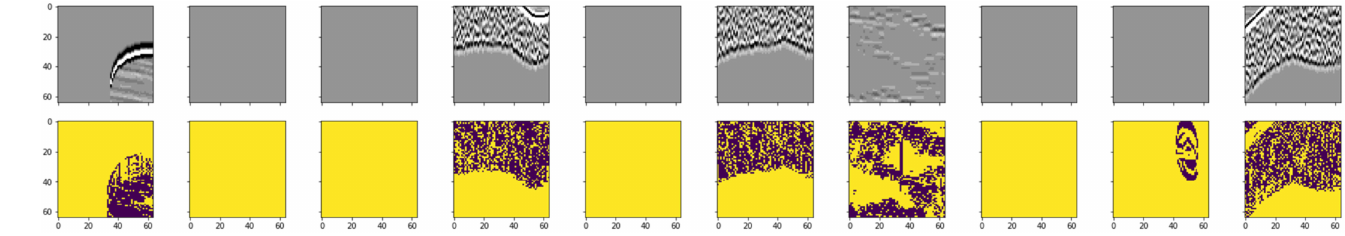
Figure 12. Example of the pairs that assigned as input (top) and output (bottom) data.